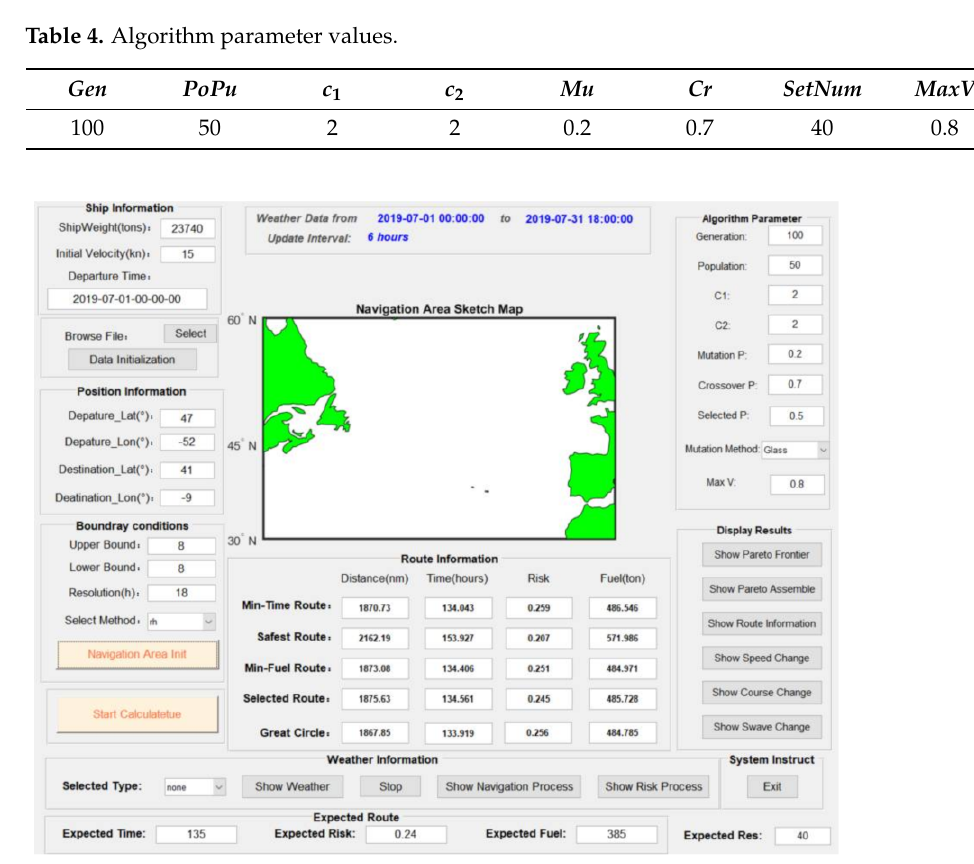
Figure 6. Multicriteria route planning simulation